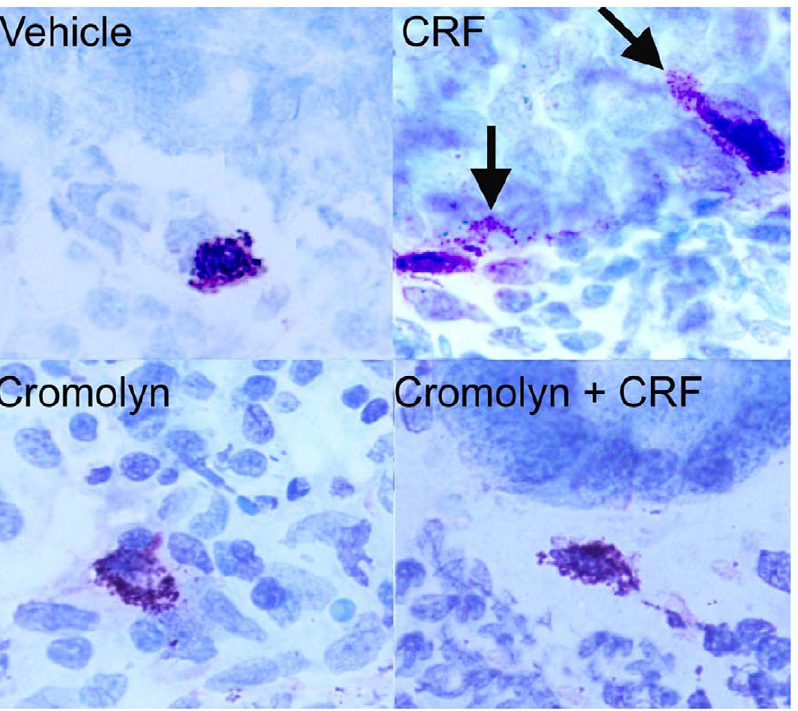
Figure 5. Histologic analysis of CRF-mediated intestinal mast cell degranulation. Treatment of porcine ileal tissues mounted on Ussing chambers with CRF caused and increase in mast cell degranulation as determined by toluidine blue staining. Arrows indicate the release of mast cell granules into surrounding tissues. Sodium cromolyn, a mast cell stabilizing agent, prevented CRF-induced mast cell degranulation. Figures are representative of ileal tissue sections from n=4